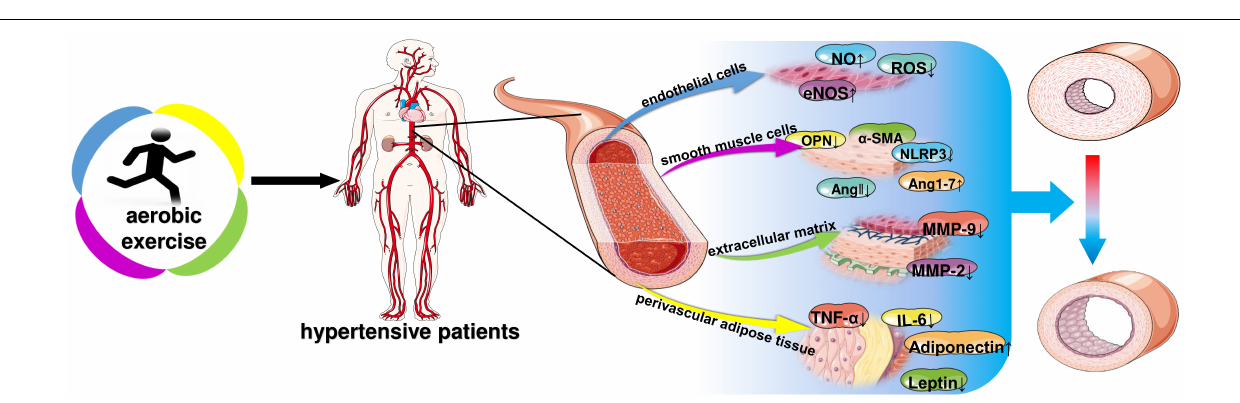
FIGURE 1 | When hypertension occurs, the continuous increase of blood pressure leads to chronic poor vascular adaptation and dysfunction. The specific manifestations are changes in the structure and function of vascular endothelial cells, smooth muscle cells, extracellular matrix, and perivascular adipose tissue. ECs, endothelial cells; VSMCs, vascular smooth muscle cells; ECM, extracellular matrix; PVAT, perivascular adipose tissue.